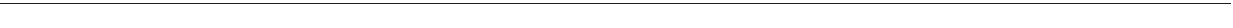
Fig. 4 B cell inability to present α -GalCer affects iNKT cell expression of genes involved in cytokine responses and metabolism. a Scatter plot showing fold- change relationships between common expressed genes ( n = 5797) in iNKT cells from B- Cd1d − / − and B-WT mice that received α -GalCer or vehicle alone following induction of arthritis (data sets from RNA-seq). Color gradient indicates the degree of difference in fold-change values between iNKT cells in B- Cd1d − / − and B-WT mice following α -GalCer treatment. b Pathway enrichment analysis of pathways (right) showing enrichment among genes expressed differentially in iNKT cells from B- Cd1d − / − and B-WT mice following α -GalCer treatment. It is presented as net pathway perturbation in iNKT cells from B- Cd1d − / − mice compared to B-WT mice. Negative values mean inhibited in iNKT cells from B- Cd1d − / − , positive values mean activated in iNKT cells from B- Cd1d . c Heat maps showing the expression of genes involved in glycolysis (top) and fatty acid oxidation (bottom) by iNKT cells from B- Cd1d − / − and B-WT mice that received α -GalCer or vehicle alone. d Heat map showing the expression of cytokine genes by iNKT cells from B- Cd1d − / − and B-WT mice that received α -GalCer or vehicle alone. e , f Volcano plots showing fold changes of differentially expressed genes associated with e NKT1 and NKT2 phenotypes, and f PLZF transcriptional regulation, between iNKT cells from B- Cd1d − / − and B-WT mice following α -GalCer treatment, plotted against p